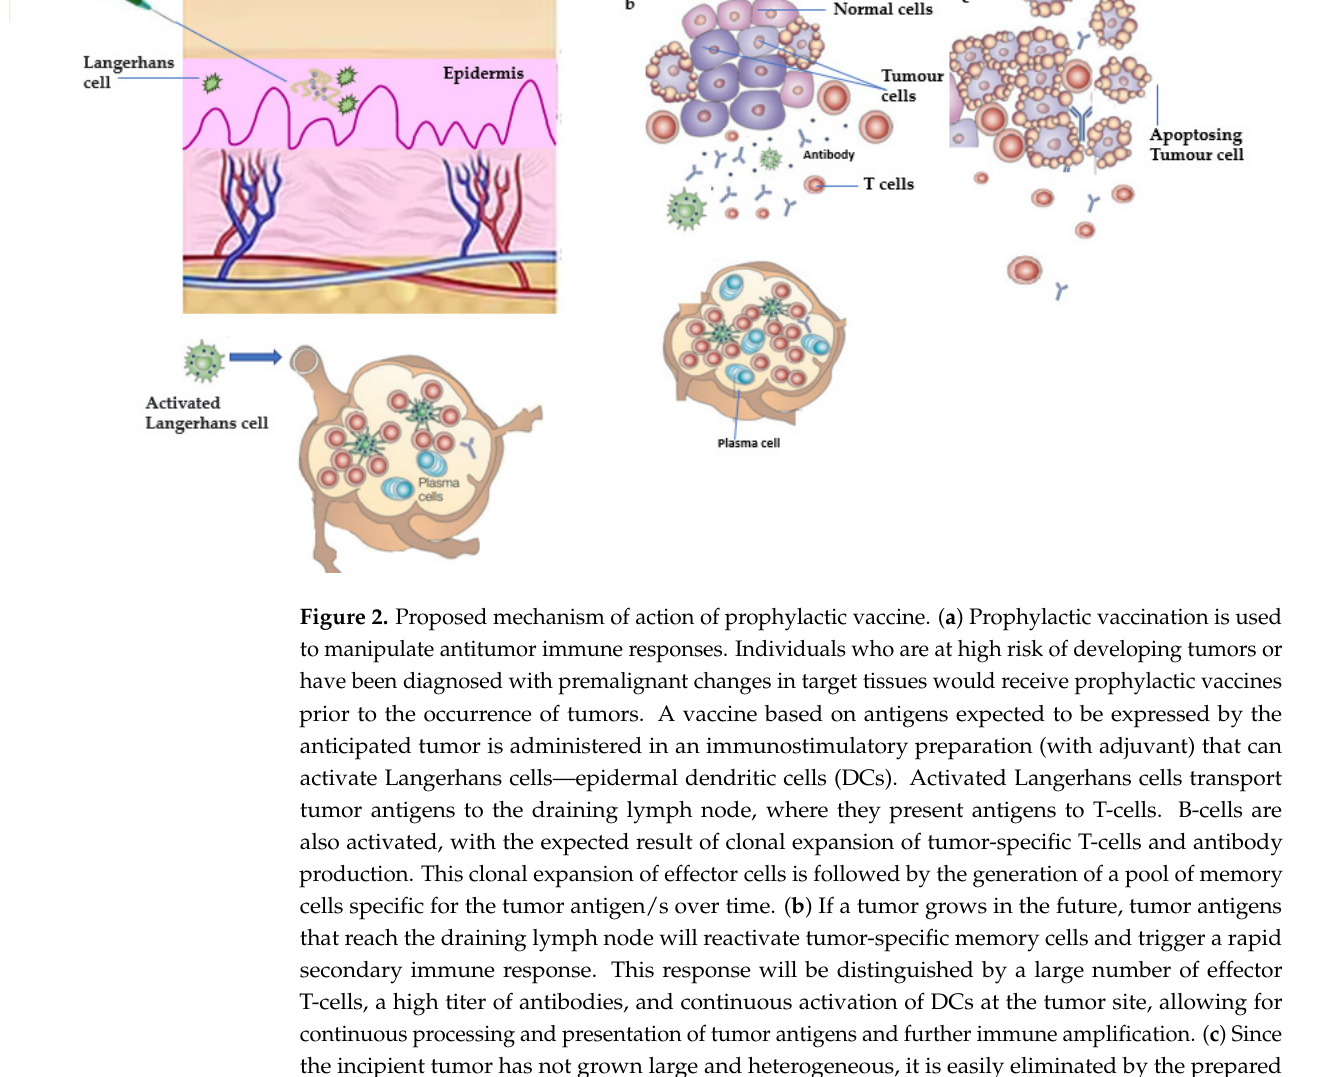
immune response. Furthermore, the memory compartment is expanded by this tumor-mediated